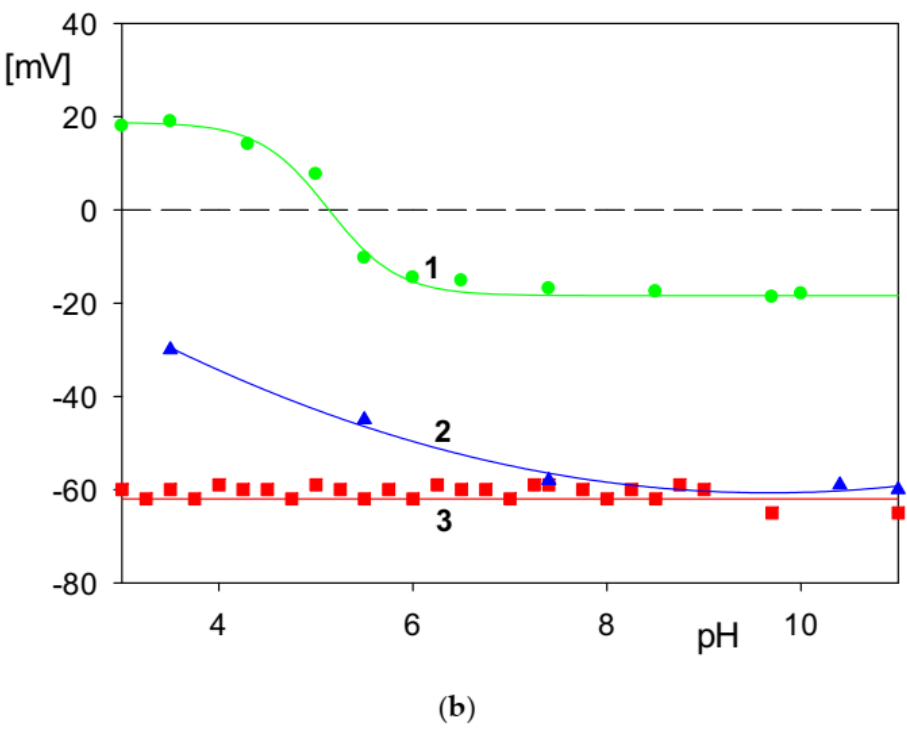
Figure 3. The dependence of the zeta potential on pH: (1) ( • ) HSA (Laser Doppler Velocimetry (LDV) method); (2) ( (cid:78) ) bare mica (streaming potential method); (3) ( (cid:4) ) microparticles (LDV method). Part ( a ) ionic strength 10 − 2 M; part ( b ) ionic strength 0.15